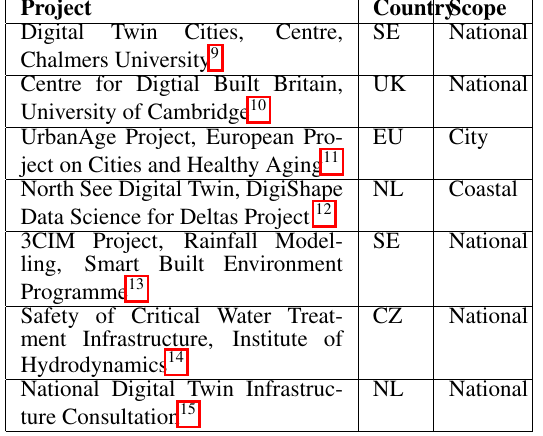
Table 2: Selection of Research Projects and Initiatives